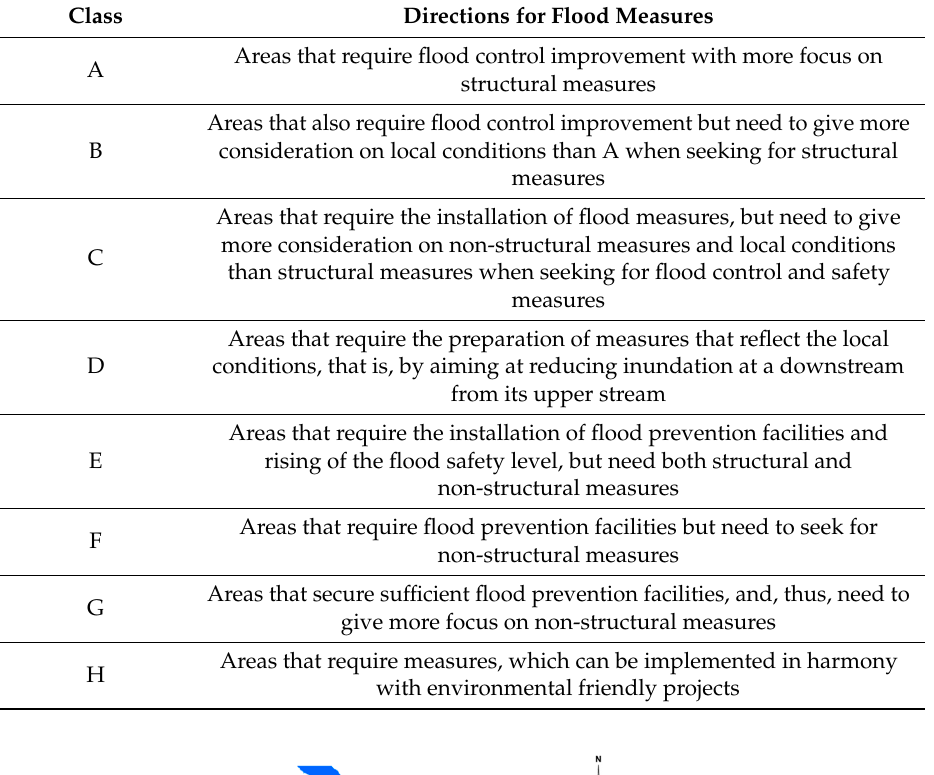
Table 3. The direction of flood measure by Potential Flood Damage (PFD) class.